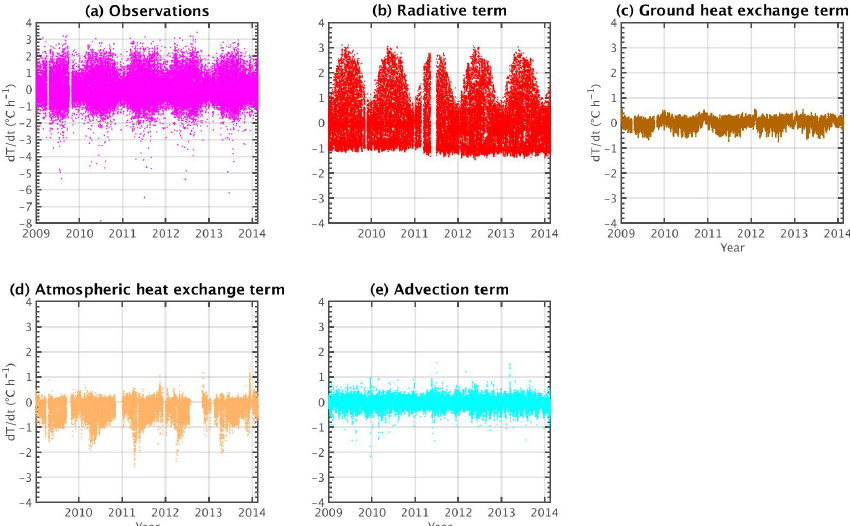
Figure A2. Hourly evolution of observations (a) , R term (b) , HG term (c) , HA term (d) , and Adv term (e) . Gaps in (d) are caused by the absence of MLD data at that